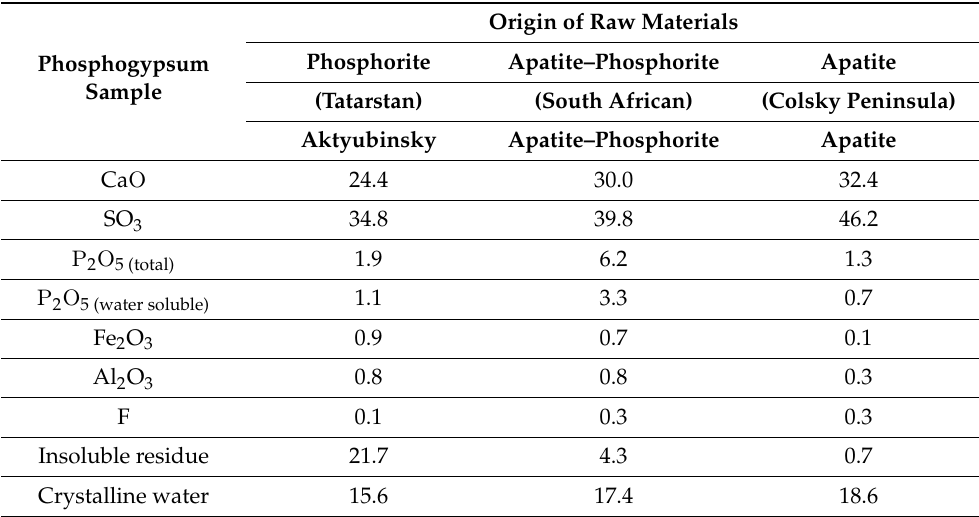
Table 1. The chemical composition of phosphogypsum converted to dihydrate depending on the type of raw material (in %)